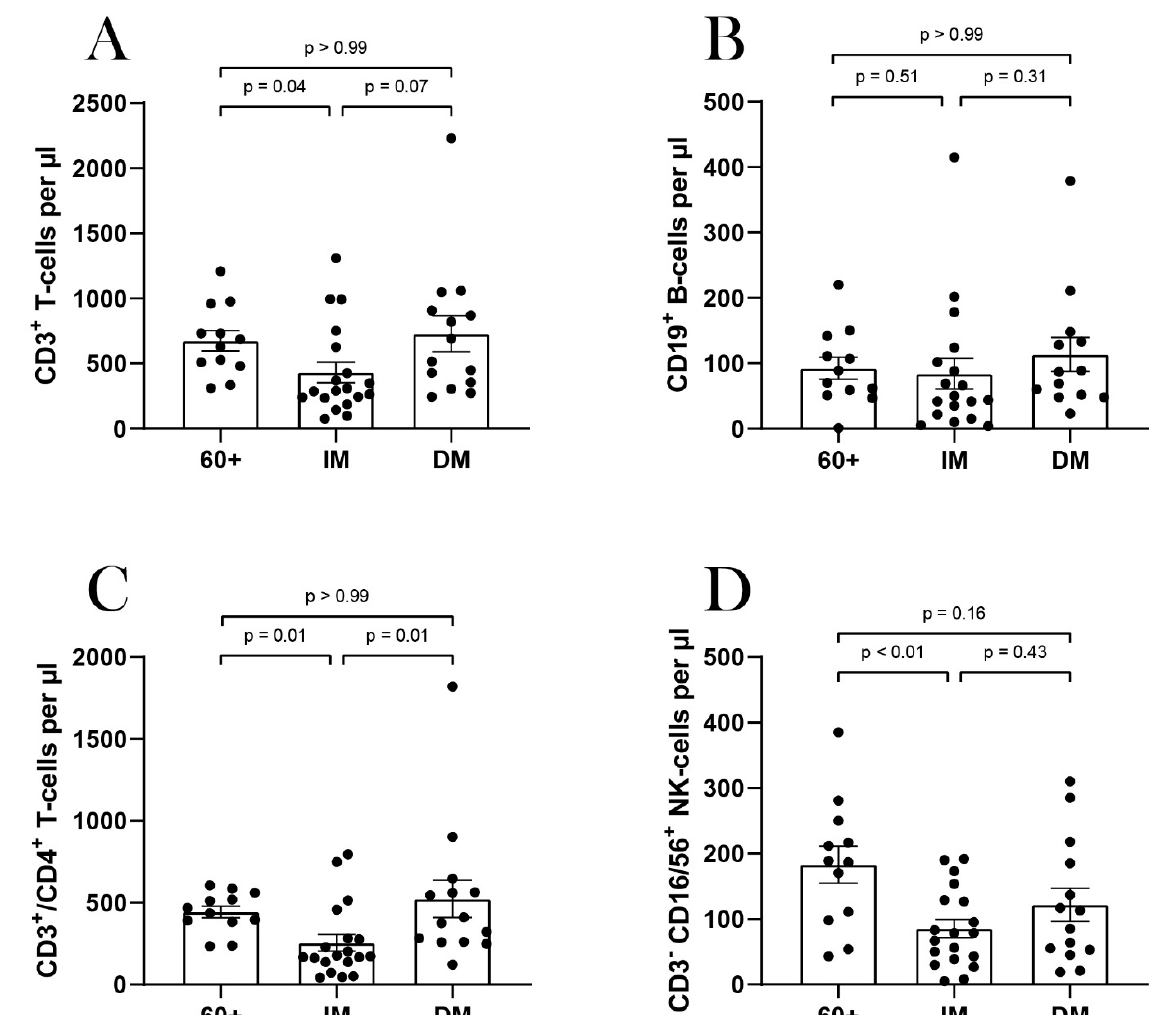
Figure 2. Cellular immune status of elderly (60+), immunocompromised (IM) and diabetes mellitus (DM) patients : Total numbers of CD3 + cells ( A ); CD19 + B-cells ( B ), CD3 − , CD16/56 + cells ( C ) and CD3 + , CD4 + T-cells ( D ) were determined for 45 patients. Each dot ( ) represents one patient. A comparison between the groups was performed with the Mann–Whitney test. Statistical significance was set at the level of p < 0.05.